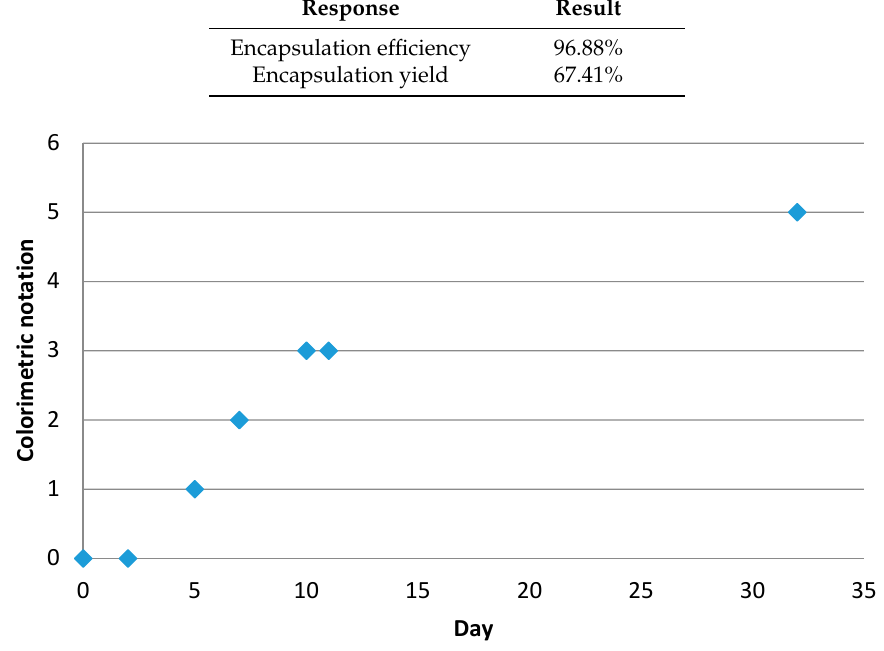
Table 8. Optimal formulation characterisation.